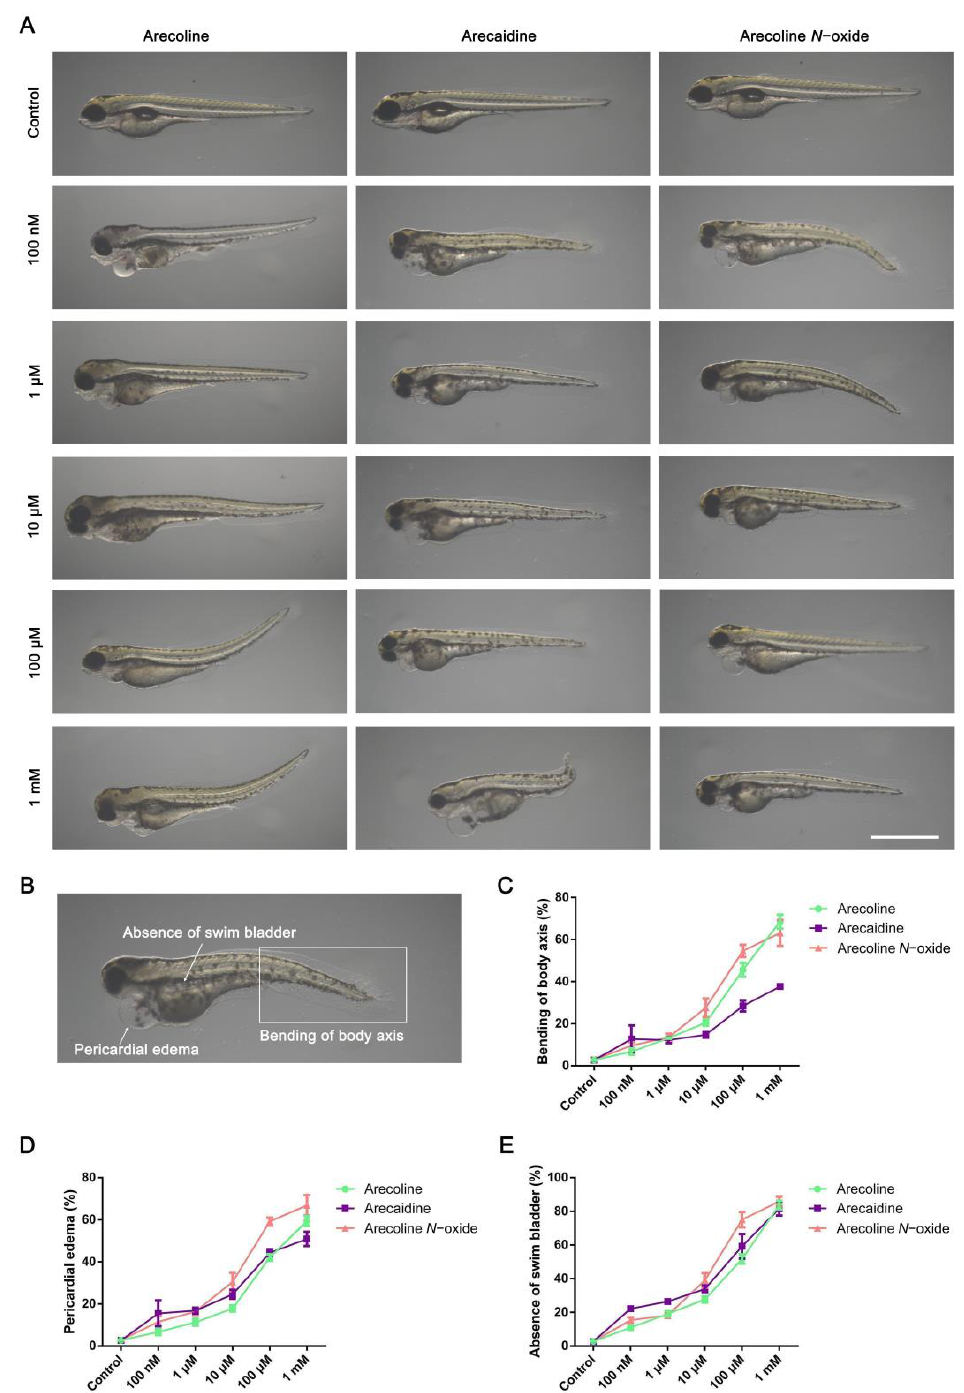
Figure 2. Qualitative and quantitative assay for bending of body axis, pericardial edema and absence of the swim bladder induced by arecoline, arecaidine and arecoline N -oxide. ( A ) Gross morphological changes after arecoline, arecaidine or arecoline N -oxide treatment at 96 hpf, scale bar = 1 mm. ( B ) Illustration of bending of the body axis, pericardial edema and absence of the swim bladder resulting from zebrafish embryo arecoline, arecaidine or arecoline N -oxide exposure. Statistics of somatic axis bending ( C ), pericardial edema ( D ) and swim bladder loss ( E ) in zebrafish embryos after exposure to arecoline, arecaidine or arecoline N -oxide. Values are presented as the mean ± SD ( n = 3). The mean, SD, p value and corresponding significance are shown in Tables S5–S7.